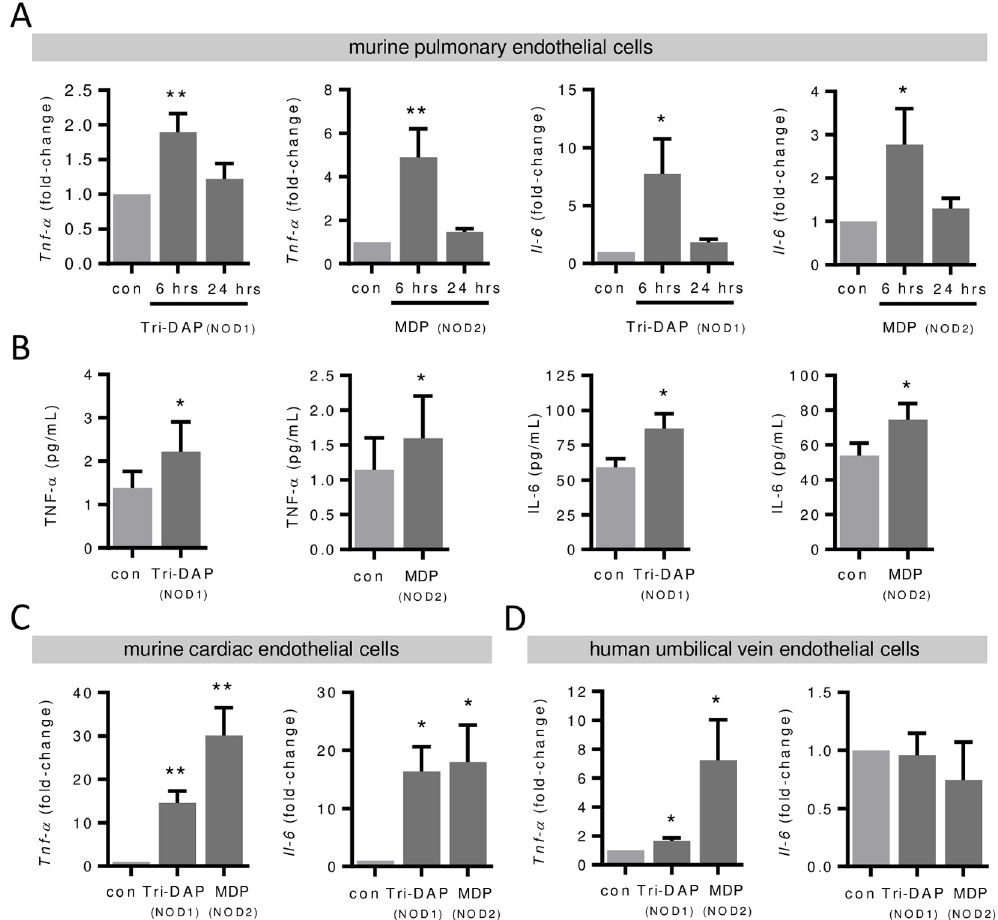
Fig 1. Induction of pro-inflammatory genes in response to NOD1 and NOD2 stimulation in different endothelial cells. Murine pulmonary endothelial cells were stimulated with Tri-DAP or MDP (each 10 μ g/mL) and ( A ) Tnf- α and Il-6 mRNA levels were analyzed after 6 and 24 hours by real-time PCR and ( B ) TNF- α and IL-6 protein levels in the supernatant after 24 hours by ELISA. � P < 0.05, �� P < 0.01 vs. unstimulated control (con), n = 5–8. Tnf- α and Il-6 mRNA levels following Tri-DAP or MDP (each 10 μ g/mL) stimulation in ( C ) murine cardiac endothelial cells and Tnf- α and Il-6 mRNA levels in ( D ) human umbilical vein endothelial cells were analyzed after 6 hours by real-time PCR. � P < 0.05, �� P < 0.01 vs. unstimulated control (con), n =